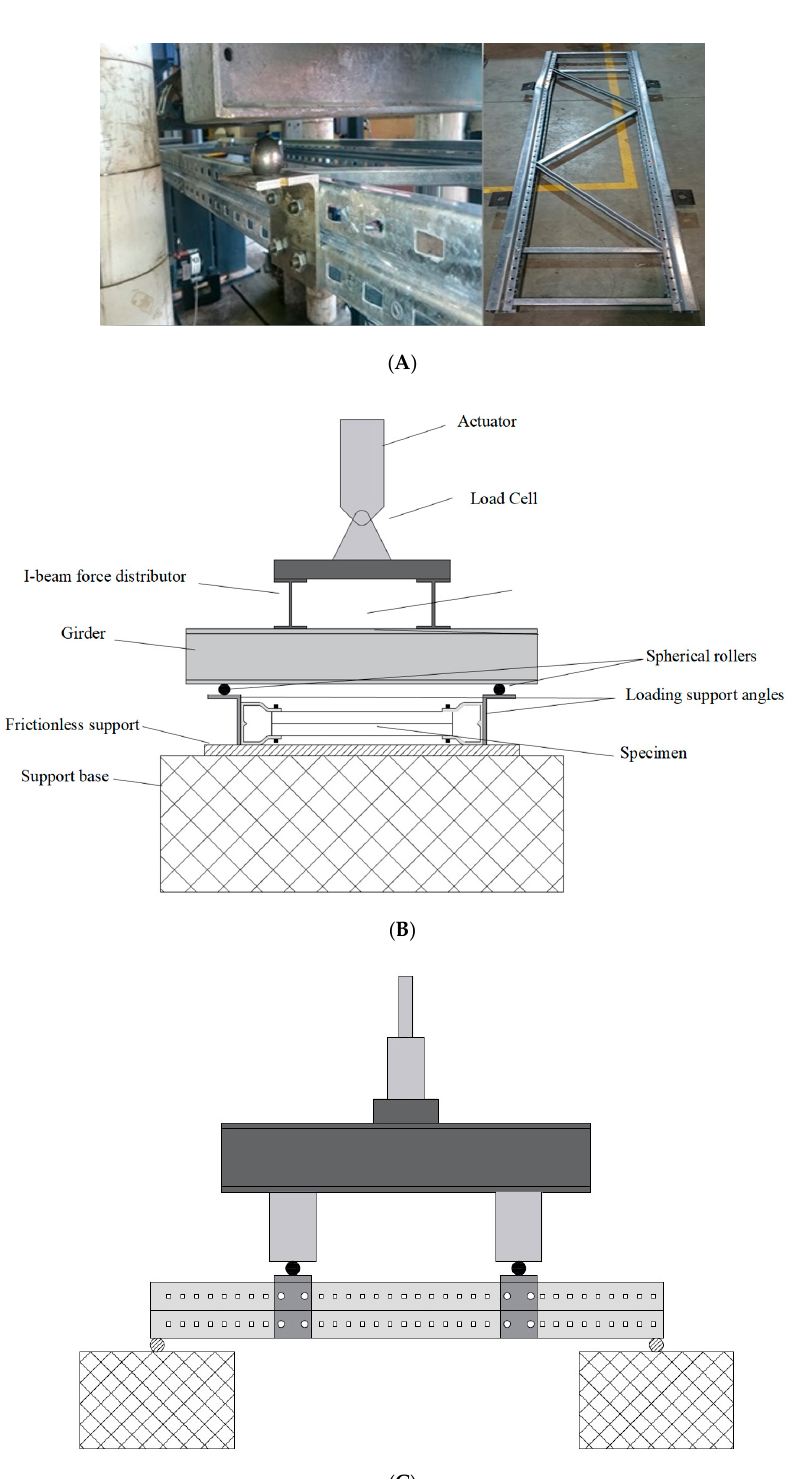
Figure 7. Major axis test set-up details: ( A ) Test specimen; ( B ) schematic front view; ( C ) schematic side view. side